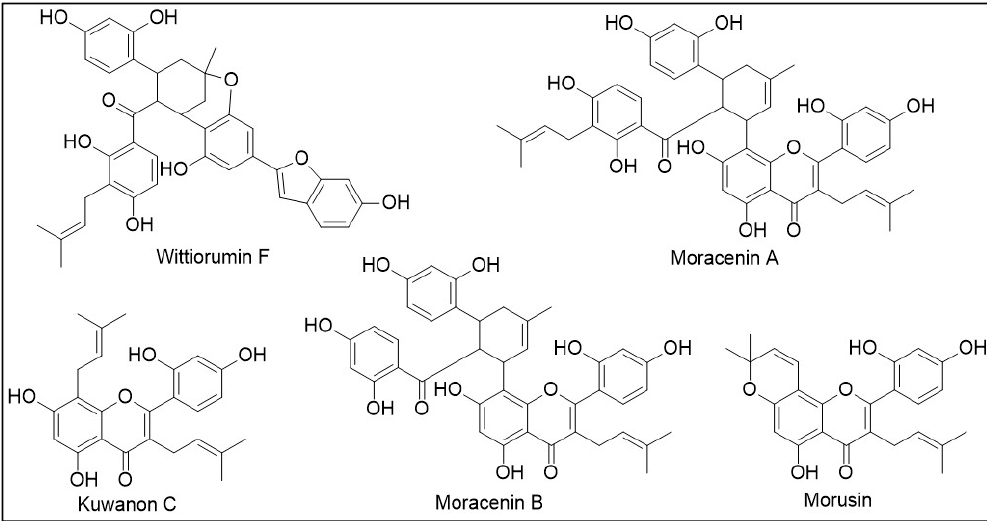
Figure A9. Chemical structures of the molecules moracenin B, kuwanon C, moracenin A, wittiorumin F and morusin.